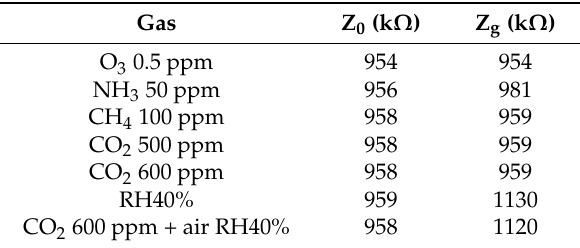
Table 6. Impedance values of SWP700-10% PVP sensor toward ozone 0.5 ppm, ammonia 50 ppm, methane 100 ppm, and carbon dioxide 500